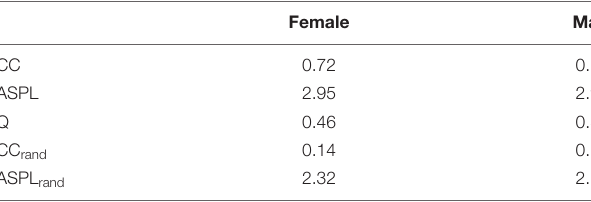
CC–clustering coefficient; ASPL–average shortest path length; Q–modularity measure; CCrand–Clustering coefficient of random graph; ASPLrand–average shortest path length of random